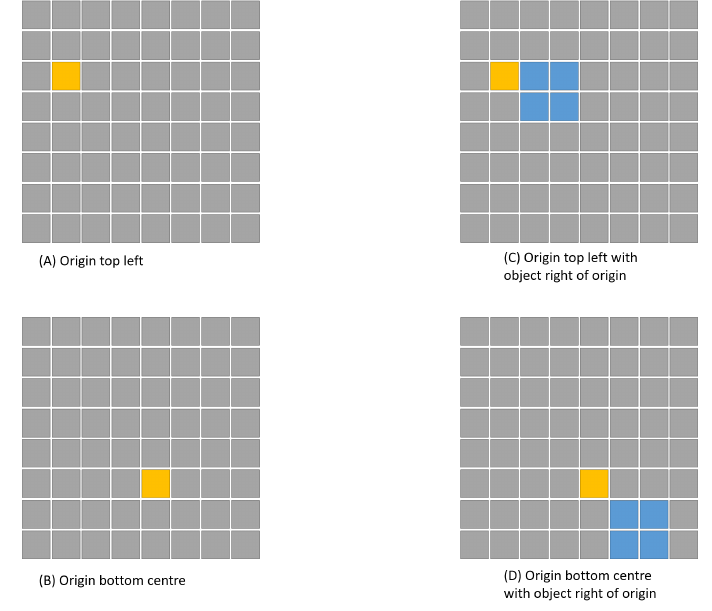
Figure 2. The figure shows the origin can be set arbitrarily when the agent first starts recording a new environment.